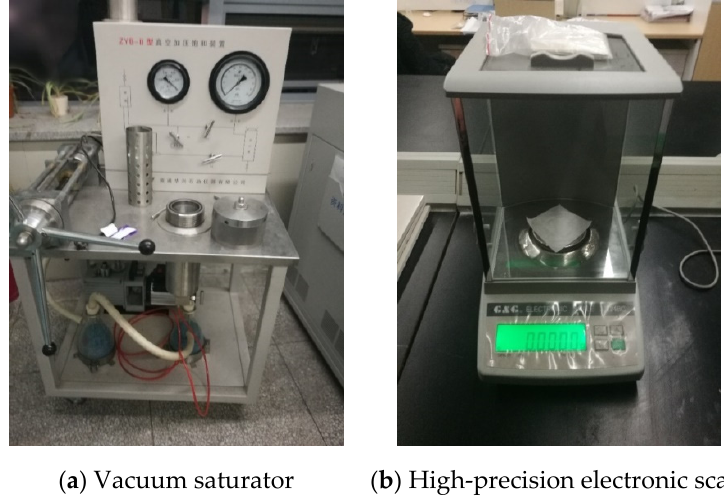
Figure 1. Test instrument.